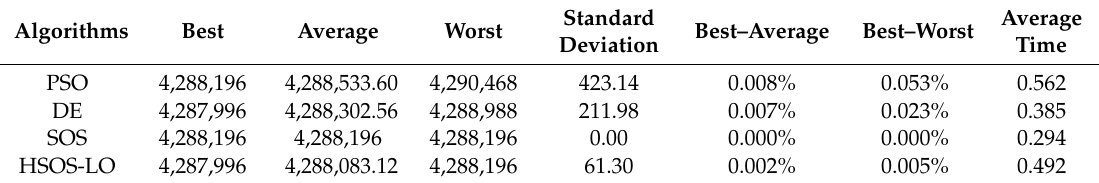
Table 5. Comparative results of DE, PSO, SOS, and HSOS-LO for Case 2.